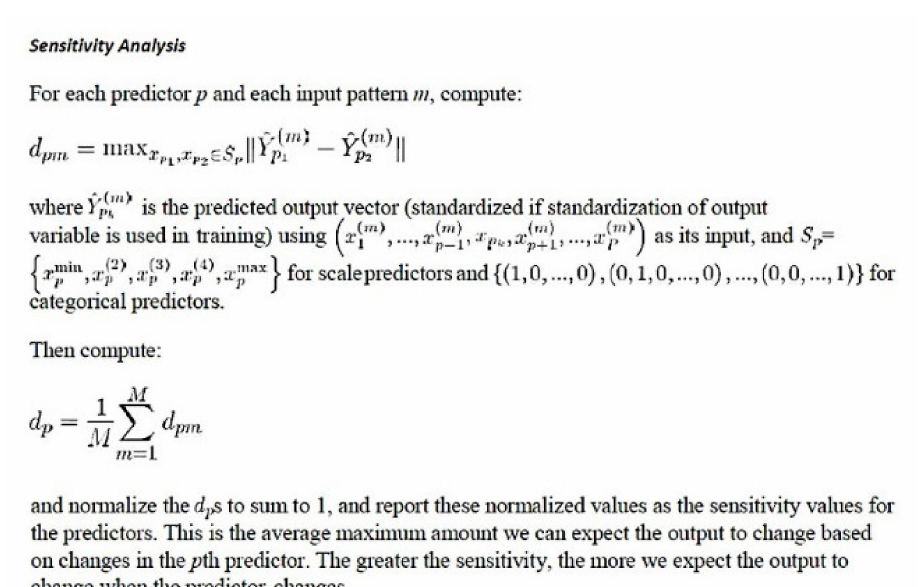
Figure 3. Sensitivity analysis. Independent variable importance analysis. Performs a sensitivity anal- ysis, which computes the importance of each predictor in determining the neural network